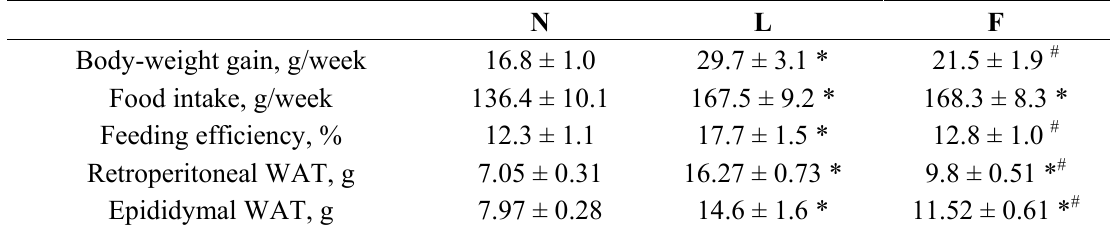
Table 1. Body weight gain, energy intake and feeding efficiency in rats fed a normal, high-lard and high-fish oil